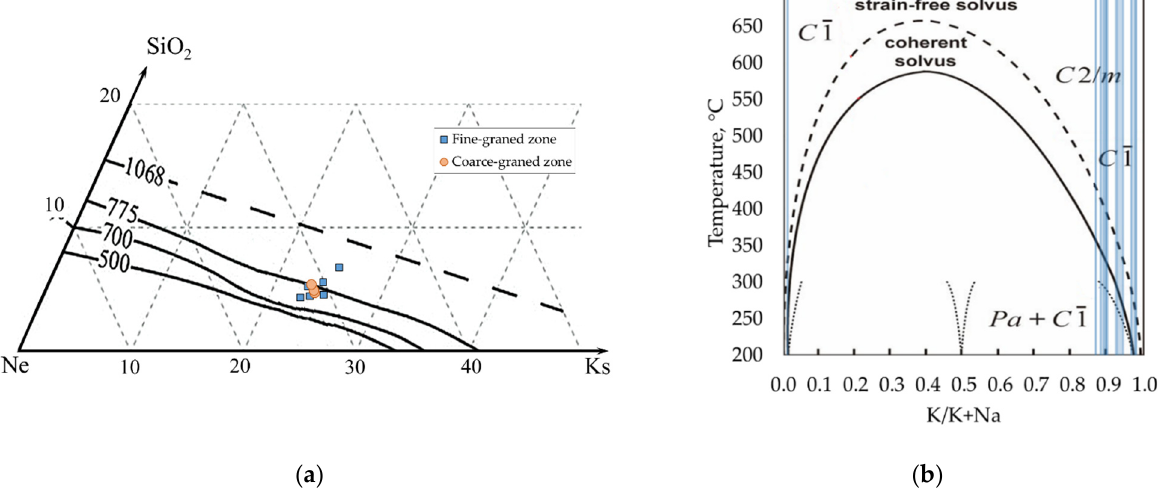
Figure 9. Nepheline and feldspar geothermometer for the peralkaline pegmatite of Odikhincha ( a ). The solvus lines ( b ) Isotherms of the solution were taken from Refs